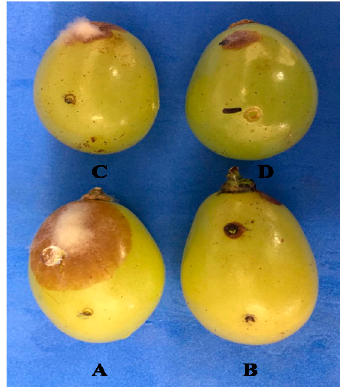
Figure 1. Indirect antifungal activity of PB, SSi and CCh at 1%. Salt solution and pathogen were added into separate wounds, ( A ): control; ( B ): PB; ( C ): SSi and ( D ): CCh.